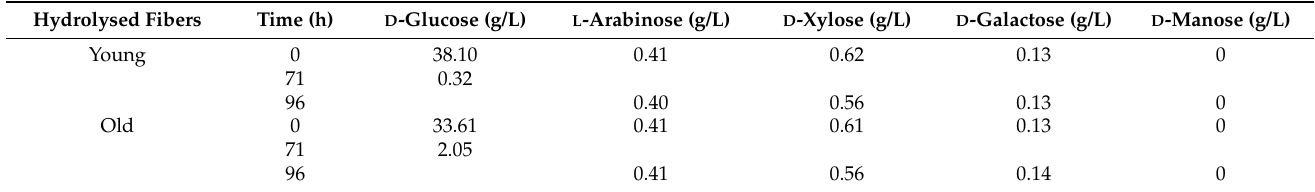
Table 6. Sugar concentrations during the fermentation processes of young and old hydrolysed fibers.